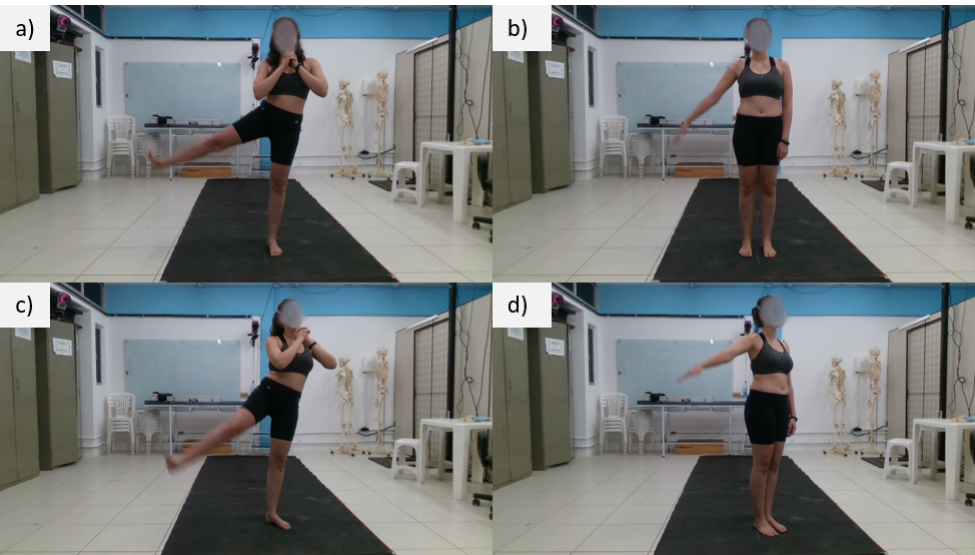
Figure 3. Movements and positioning of the volunteers during the exercises. ( a ) Movement of the LE facing the sensors. ( b ) Movement of the UE facing the sensors. ( c ) Movement of the LE inclined to the sensors. ( d ) Movement of the UE inclined to the